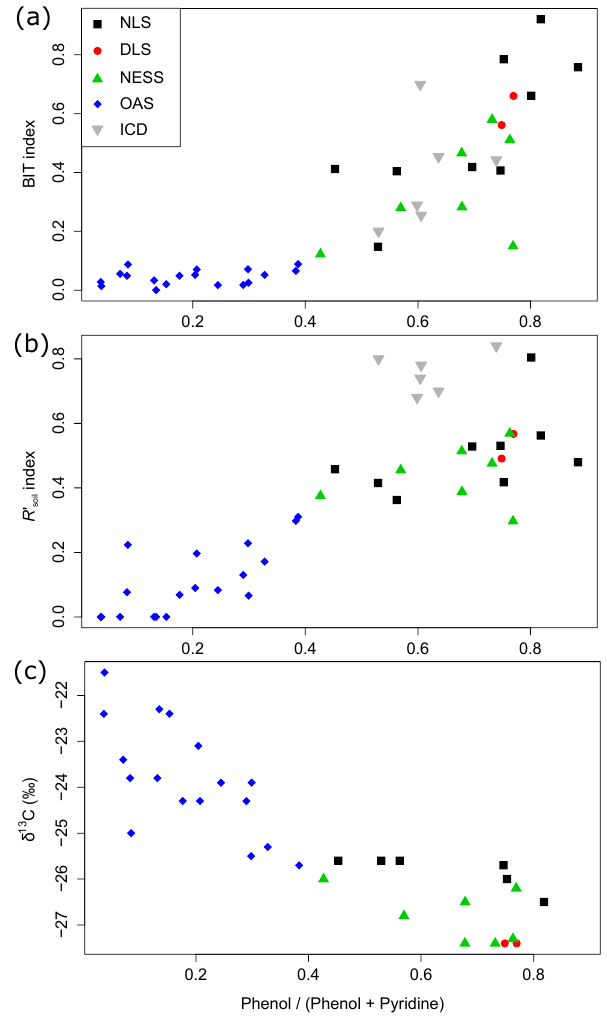
Figure 5. The phenol/pyridine ratio plotted against (a) BIT, (b) R (cid:48) soil and (c) δ 13 C OC . In each case there is a strong correlation between the proxies. (DLS: Dmitry Laptev Strait; NLS: nearshore Laptev Sea; NESS: nearshore East Siberian Sea; OAS: offshore Arctic